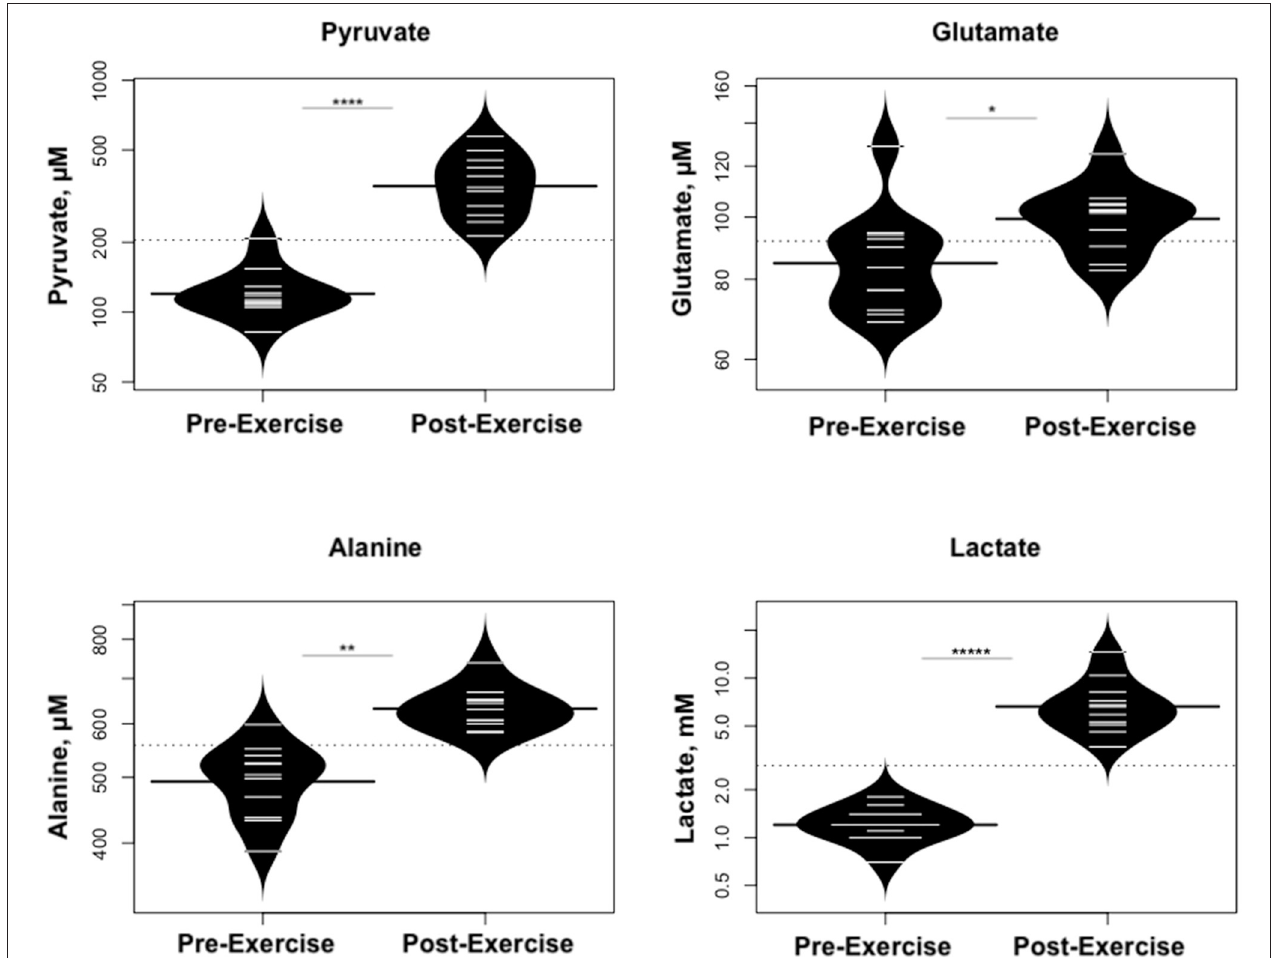
FIGURE 2 | Changes in metabolites related to interplay between the skeletal muscle and liver in maintaining blood glucose levels and disposition of the nitrogen waste through the urea cycle (Cori and Cahill Cycles). * p < 0.01, ** p < 0.001, **** p < 0.00001, ***** p < 0.000001.